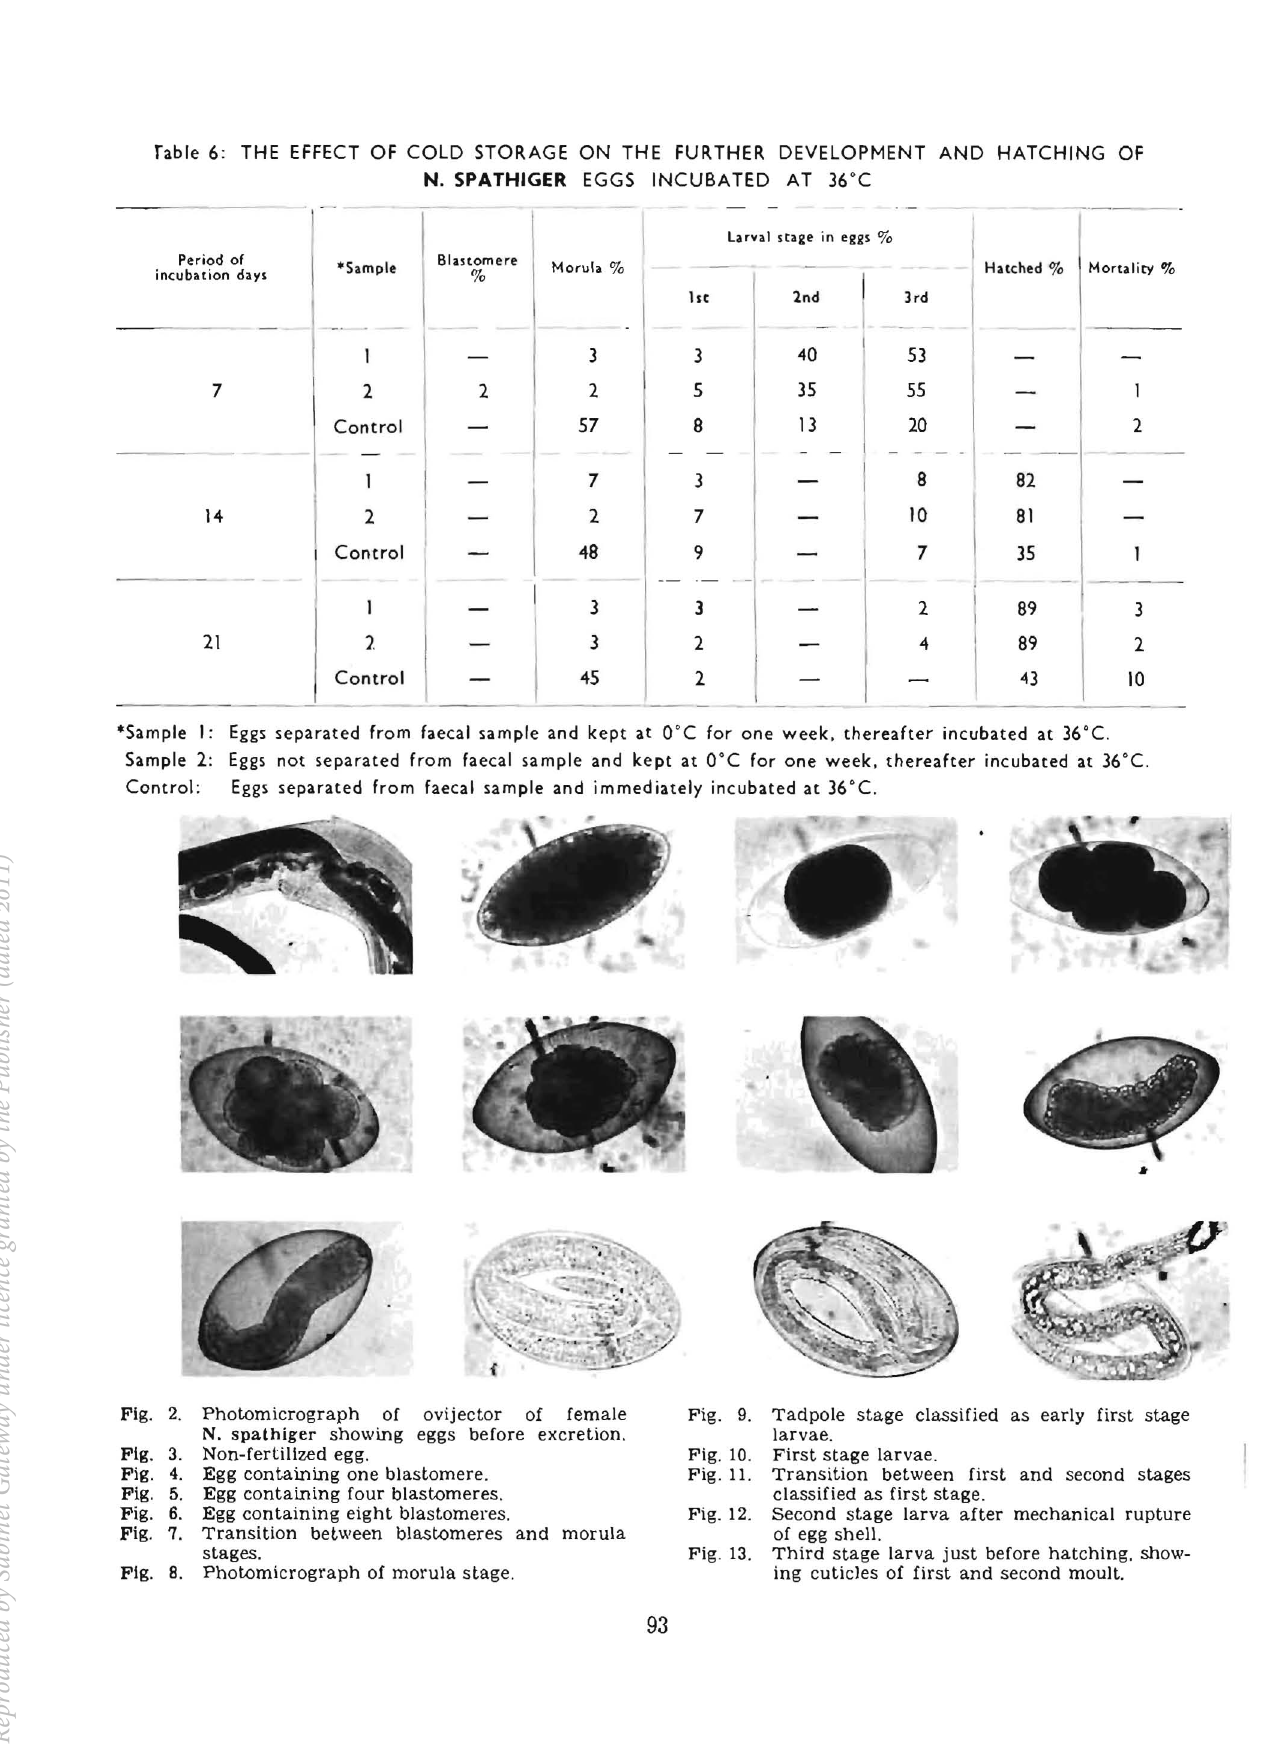
Tadpole stage classified as early first stage larvae. First stage larvae. Transition between first and second stages classified as first stage. Second stage larva after mechanical rupture of egg shell. Third stage larva just before hatching. show ing cuticles of first and second